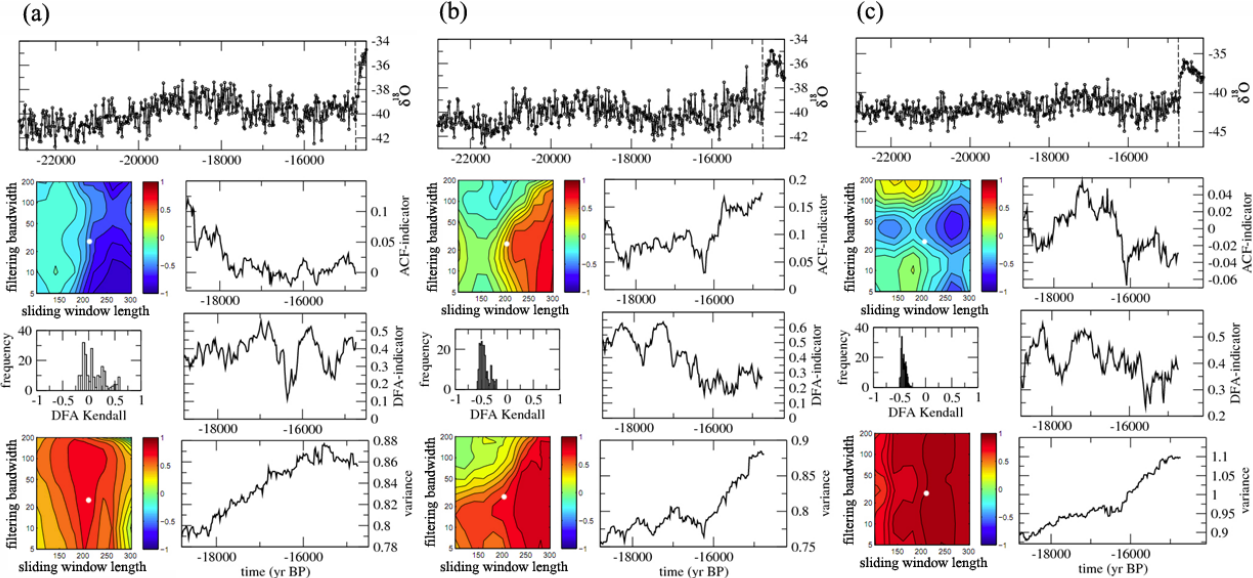
Fig. 5. Indicators of slowing down and changing variance in Greenland ice-core δ 18 O paleo-temperature proxy records during the interval after DO event 2 to the Bølling warming (DO event 1): (a) GRIP (b) GISP2 (c) NGRIP. Here the analysis spans 22.88–14.74ka ( n =408), stopping at the vertical dashed line before the Bølling warming. Otherwise panel descriptions are as in Fig. 3.